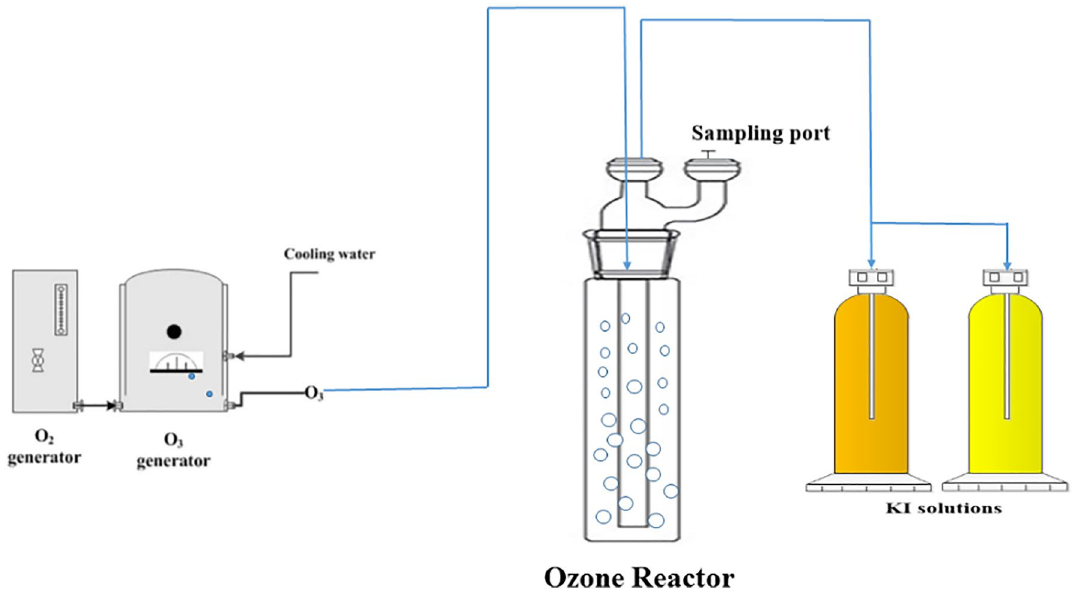
Figure 1. Schematic diagram of the